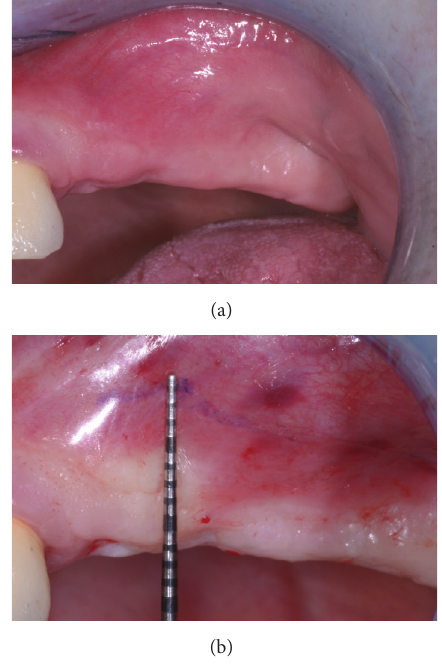
Figure 7: The clinical appearance of the edentulous posterior maxilla (a) and the flap design (b) at no more than 10mm from the